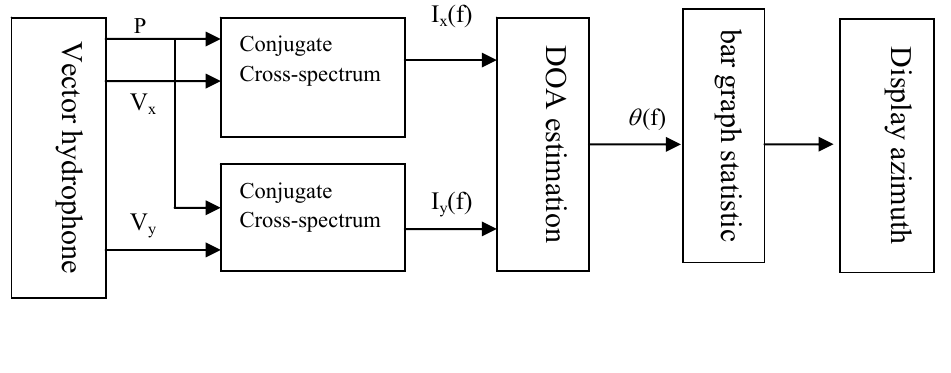
Figure 8. Principle chart of the bar graph